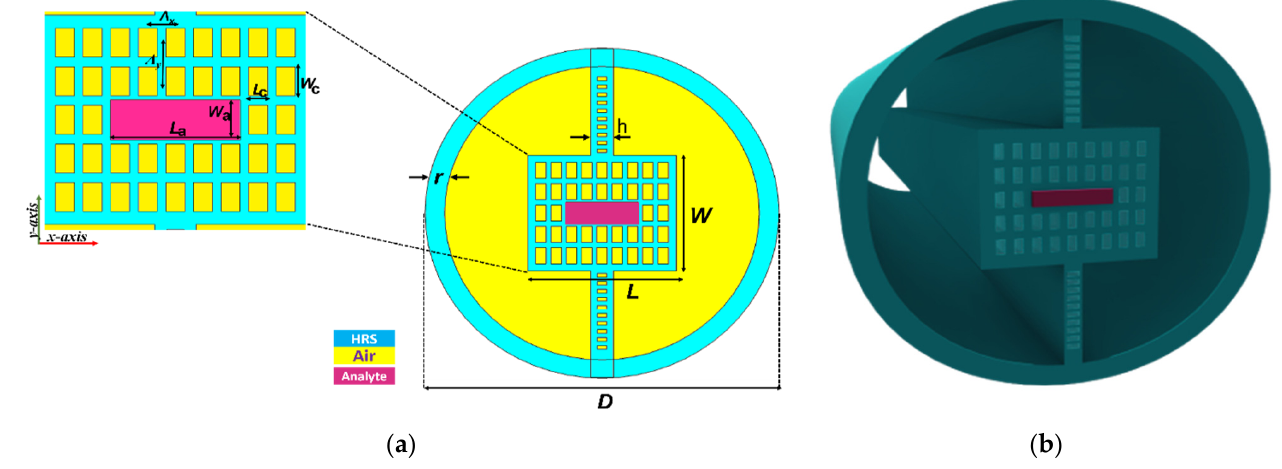
Figure 1. ( a ) 2D cross-sectional diagram; ( b ) 3D view of the suggested biosensor. Table 1. The initial geometrical parameters of the proposed biosensor design.